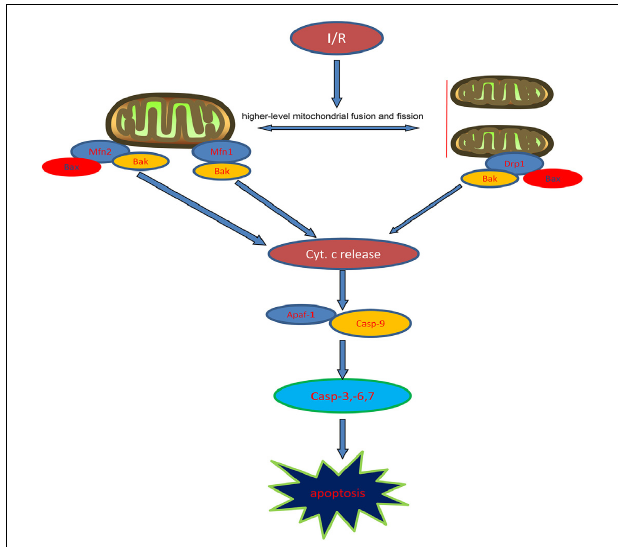
FIGURE 8 | Diagram of mitochondrial dynamics regulating intrinsic apoptosis